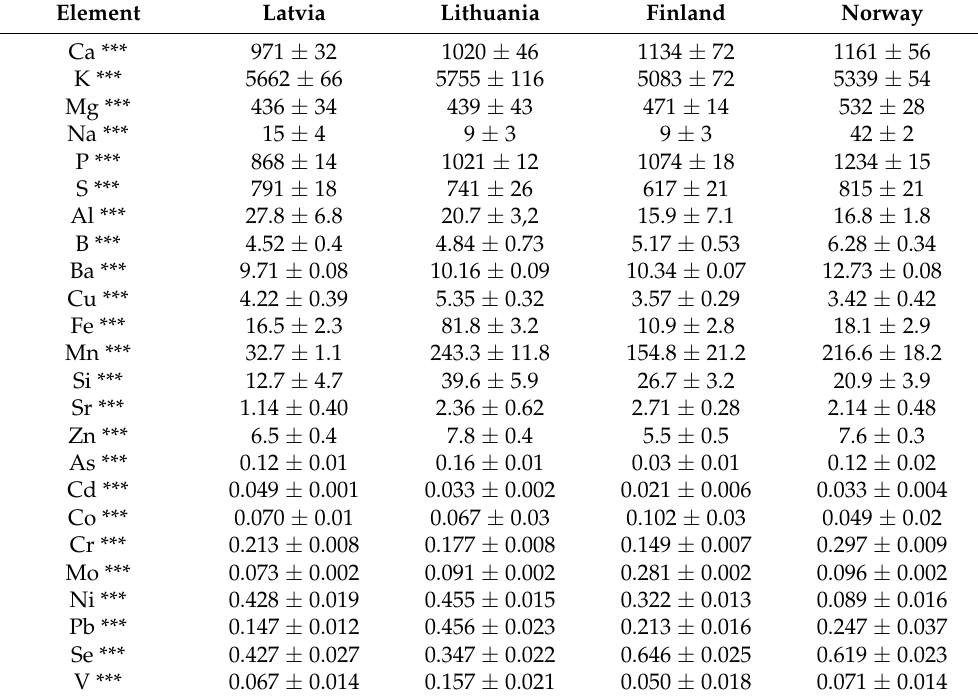
Table 3. Concentrations (mg/kg) of elements in bilberry samples from Northern Europe.